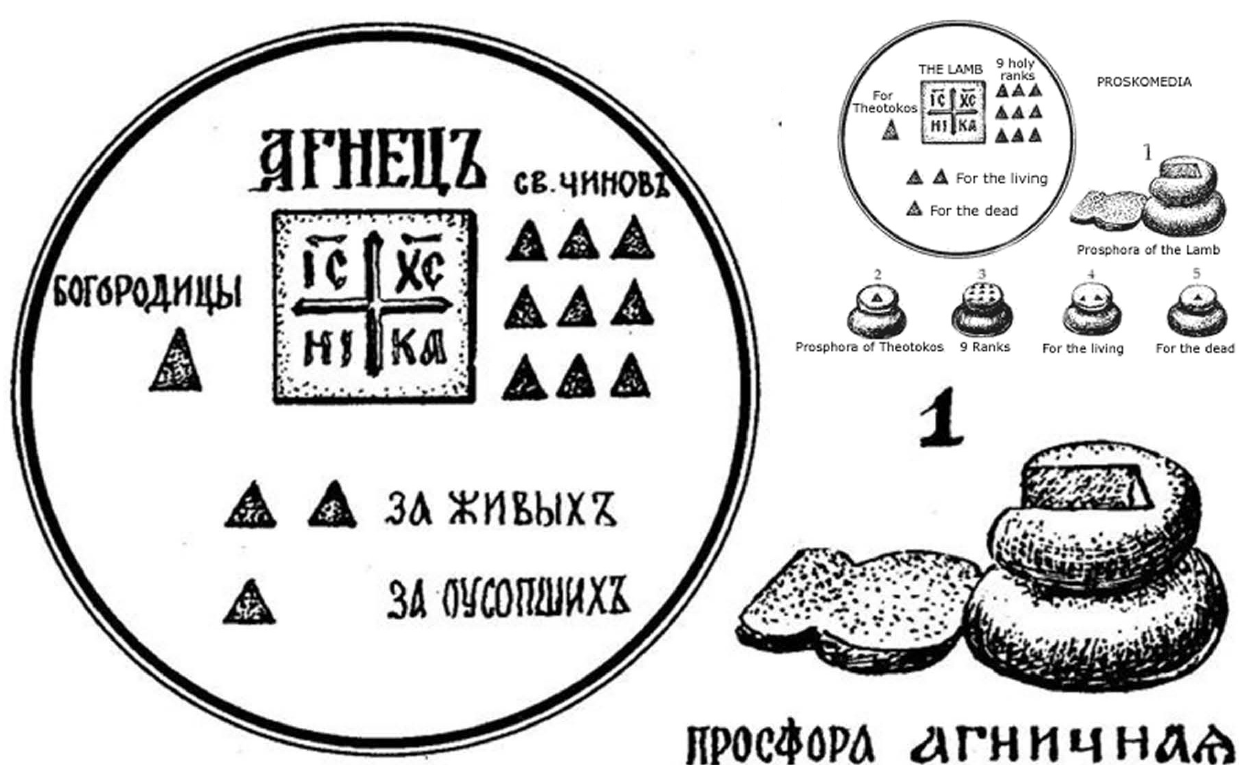
Figure 1. The Prosphora of the Lamb. Adapted from Slobodskoi (1967, p. 645).